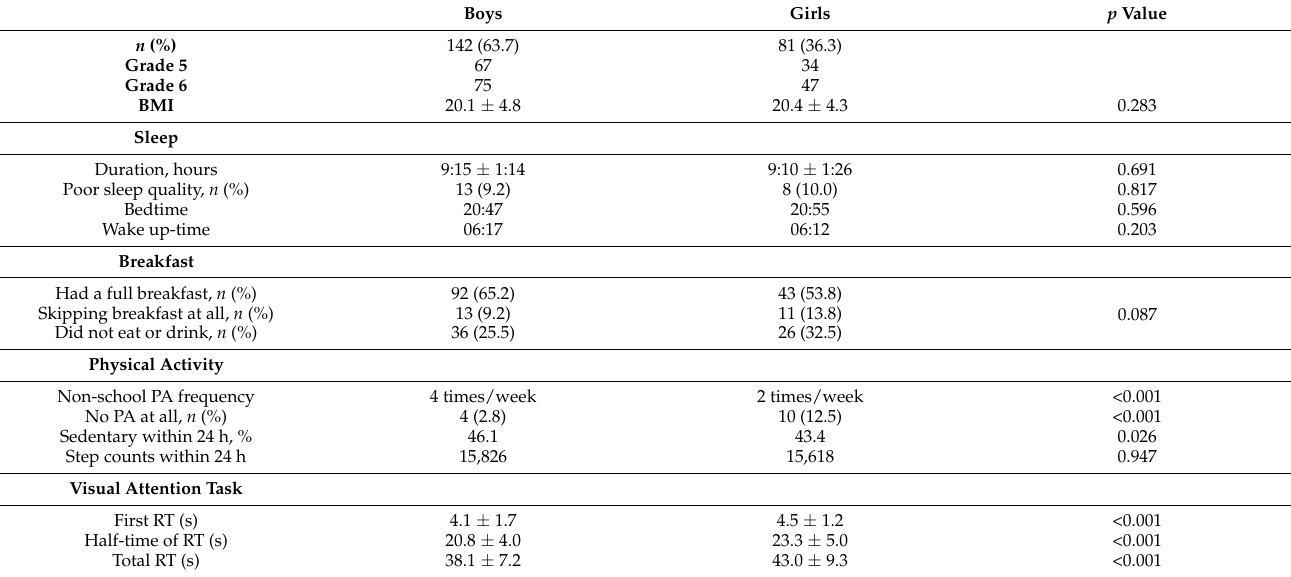
Table 1. Participants’ characteristics ( n =